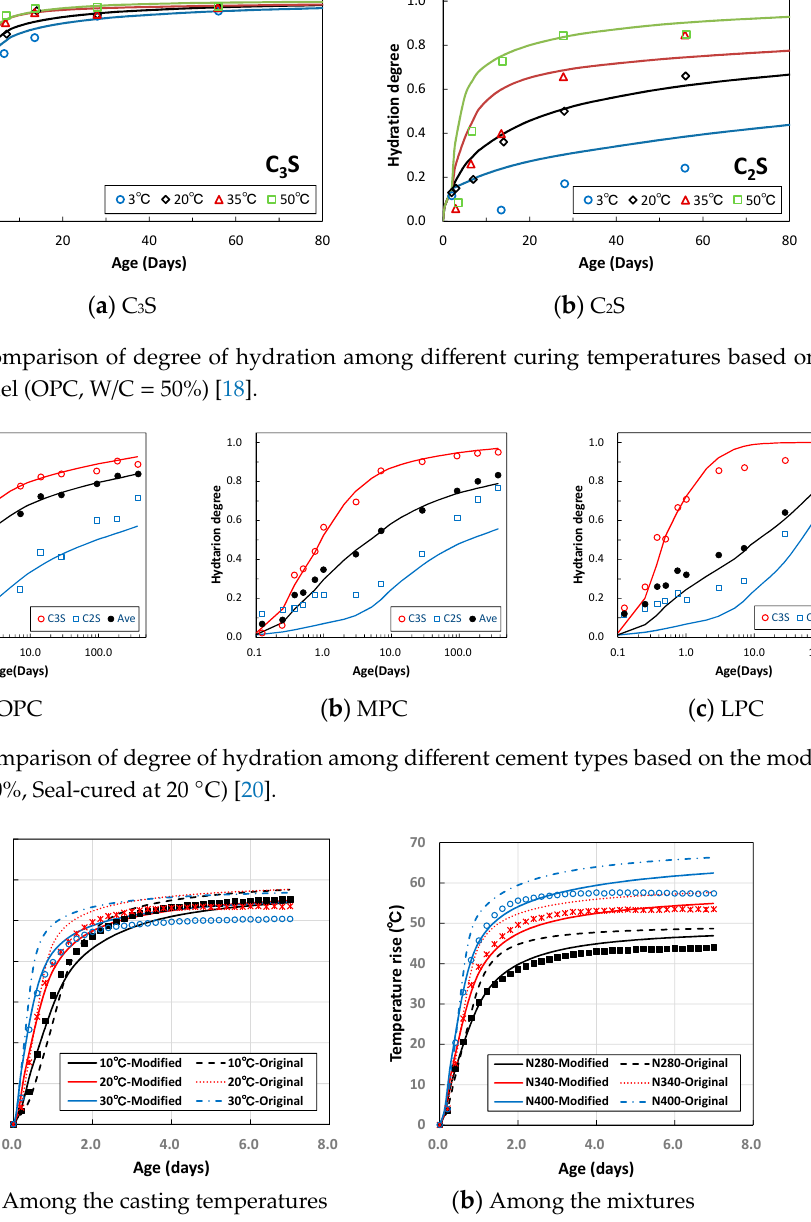
Figure 13. Comparison of adiabatic mass temperature rises based on the modified model [23].